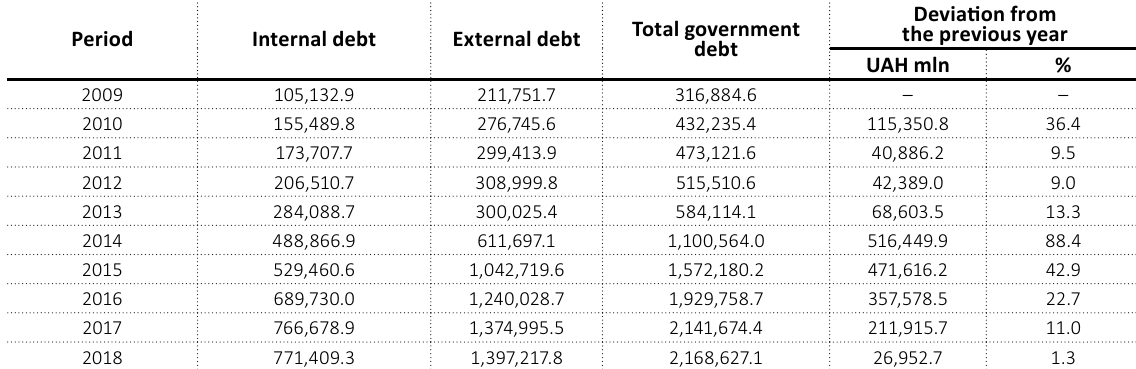
Table 4 examines the dynamics of government